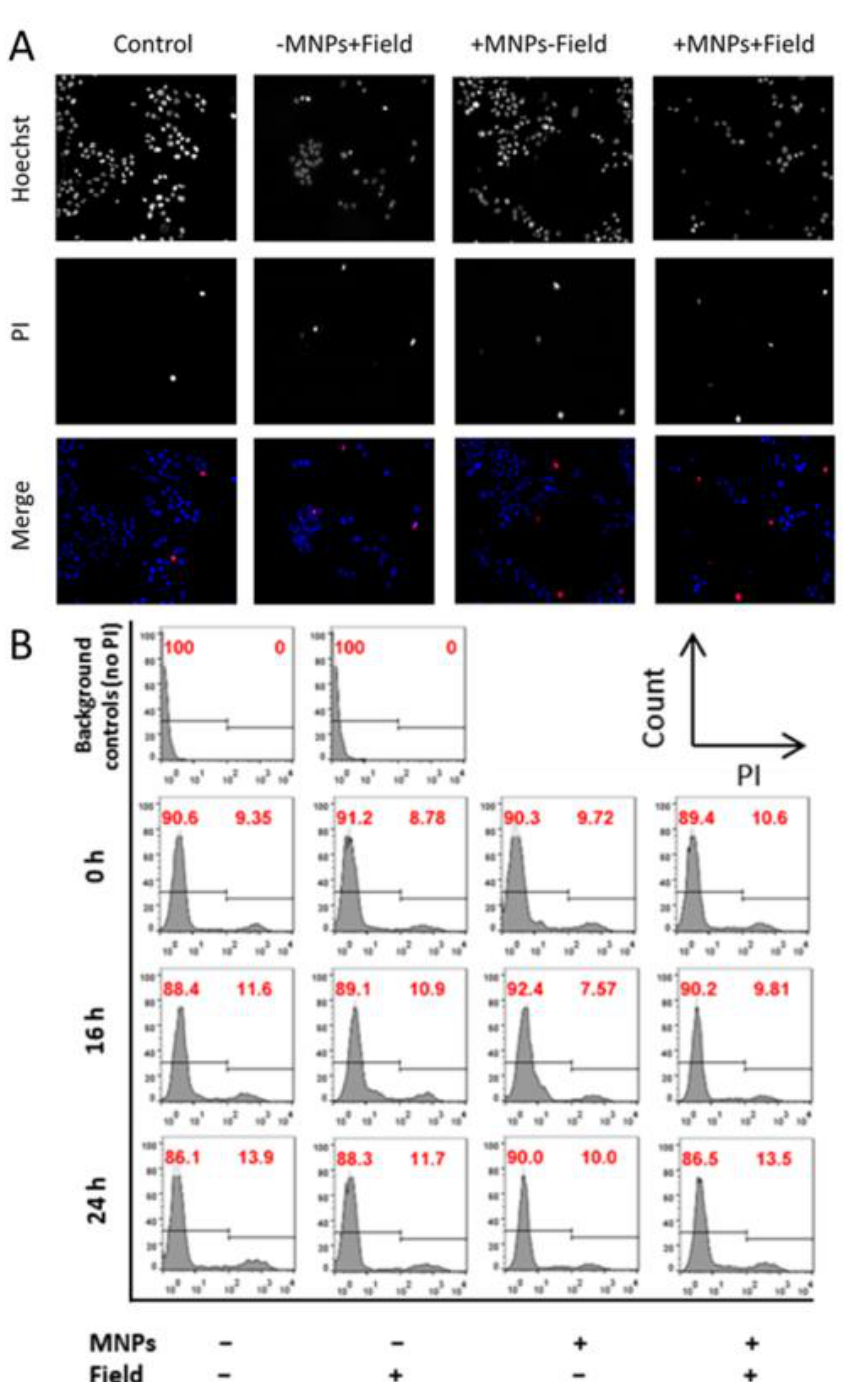
Figure 2. Propidium iodide live/dead cells analysis. ( A ) Fluorescence microscopy images of HT29 cells stained with the fluorescent DNA dyes Hoechst (blue) and PI (red). Nuclei of live cells appear blue, while nuclei of dead cells appear red. Cells were treated with MNPs (100 μg /mL, 48 h) and/or exposed to a static magnetic field of 200 mT and left undisturbed for 16 h before analysis. ( B ) Flow cytometry analysis of cell death. HT29 cells were treated with MNPs and/or exposed to a static magnetic field of 200 mT. The analysis of cell death was performed by PI exclusion. Cells were analyzed on a flow cytometer immediately (0 h), 16 h, or 24 h after the magnetic field exposure. Numbers in histograms indicate the percentage (%) of cells within each respective gate relative to the whole cell population. Results presented are representative of three independent experiments.